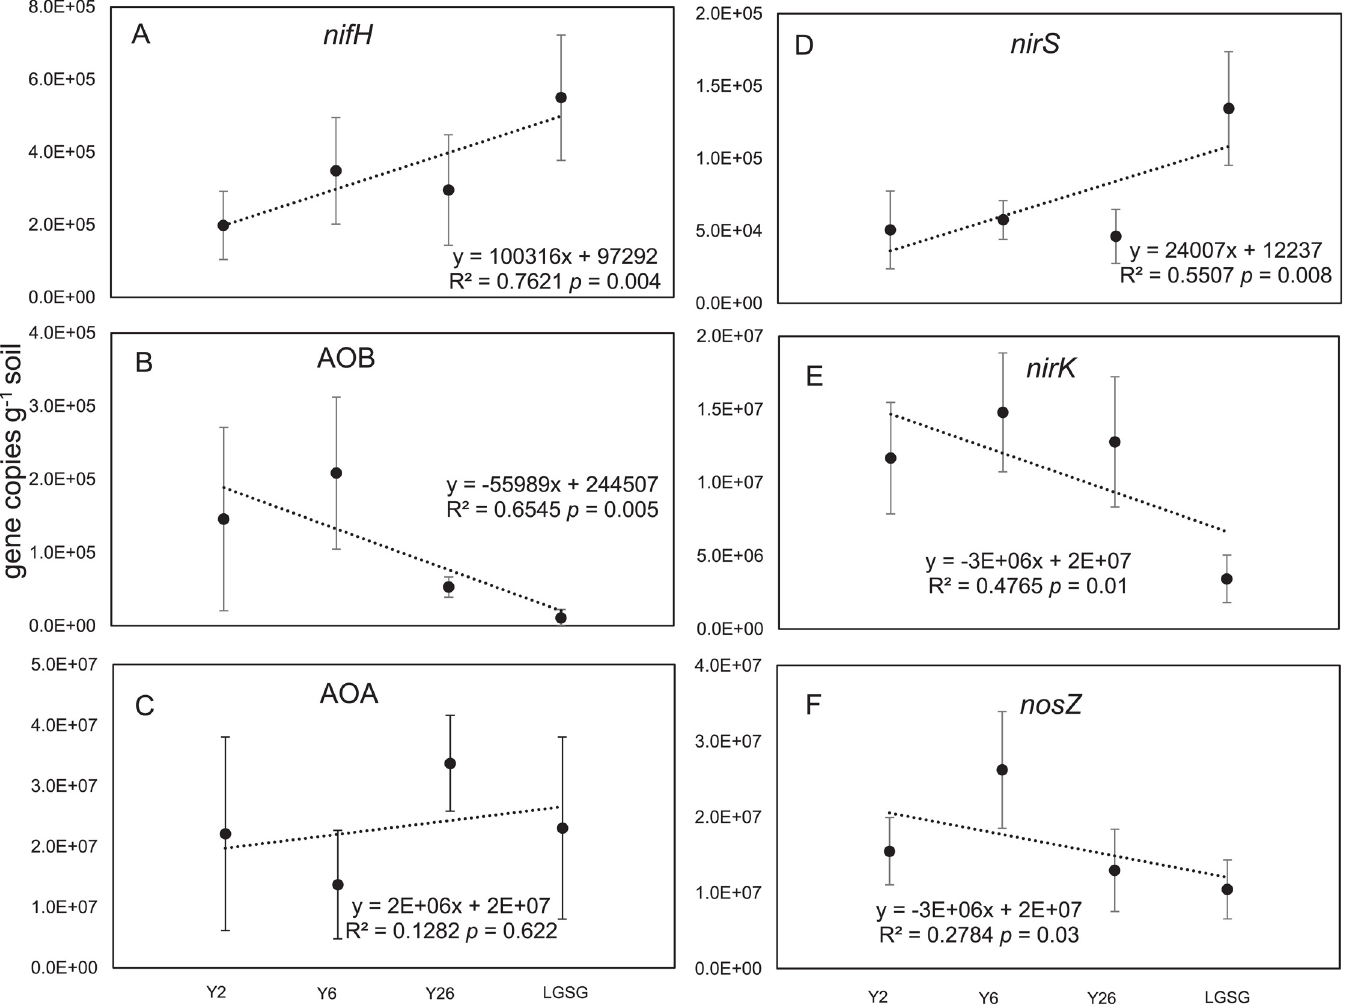
Fig 2. The results of linear regression between nitrogen-cycle gene copy numbers (log scale) and cropland abandonment period. (A), nifH gene; (B), AOB gene; (C), AOA gene; (D), nirS gene; (E), nirK gene; (F), nosZ gene. The regression lines are shown with R 2 .